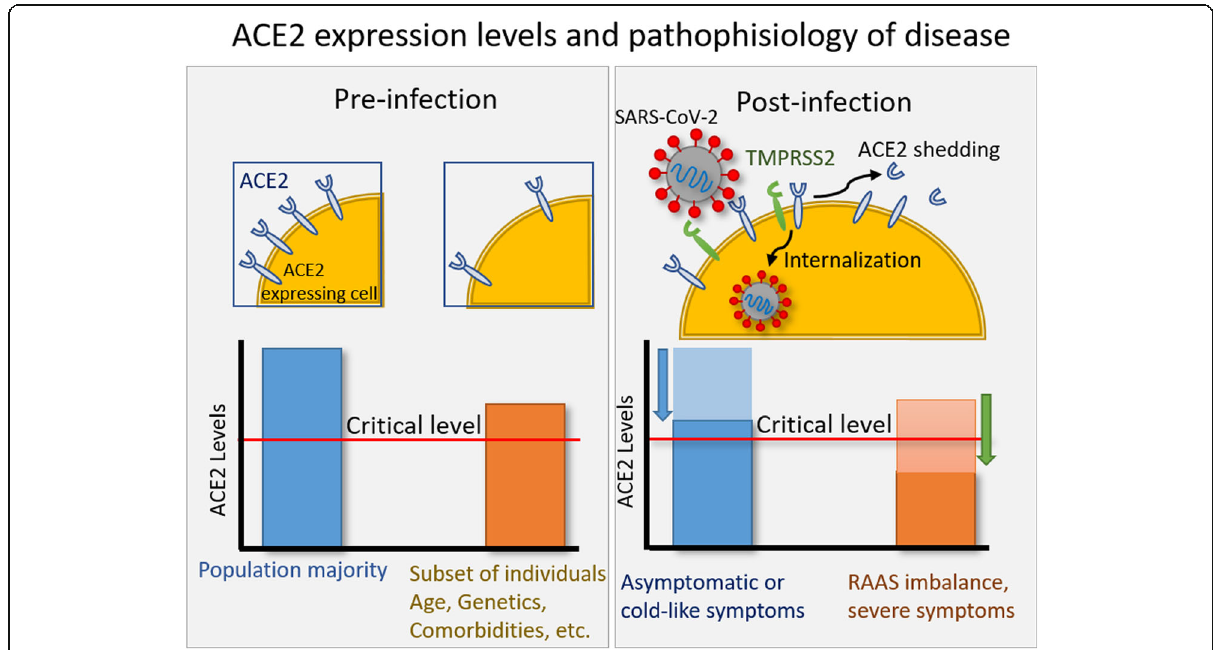
Fig. 2 The effect of ACE2 expression levels on COVID-19 disease and severity. Age, genetics, and different comorbidities affect the pre-infection ACE2 expression levels in a subset of individuals (left), rendering them susceptible to severe forms of disease. During infection (right), upon interaction of SARS-CoV-2 S protein with ACE2 and TMPRSS2, ACE2 levels are downregulated. Those individuals with low pre-infection ACE2 levels reach a threshold critical value corresponding to the onset of severe symptomathologies due to RAAS